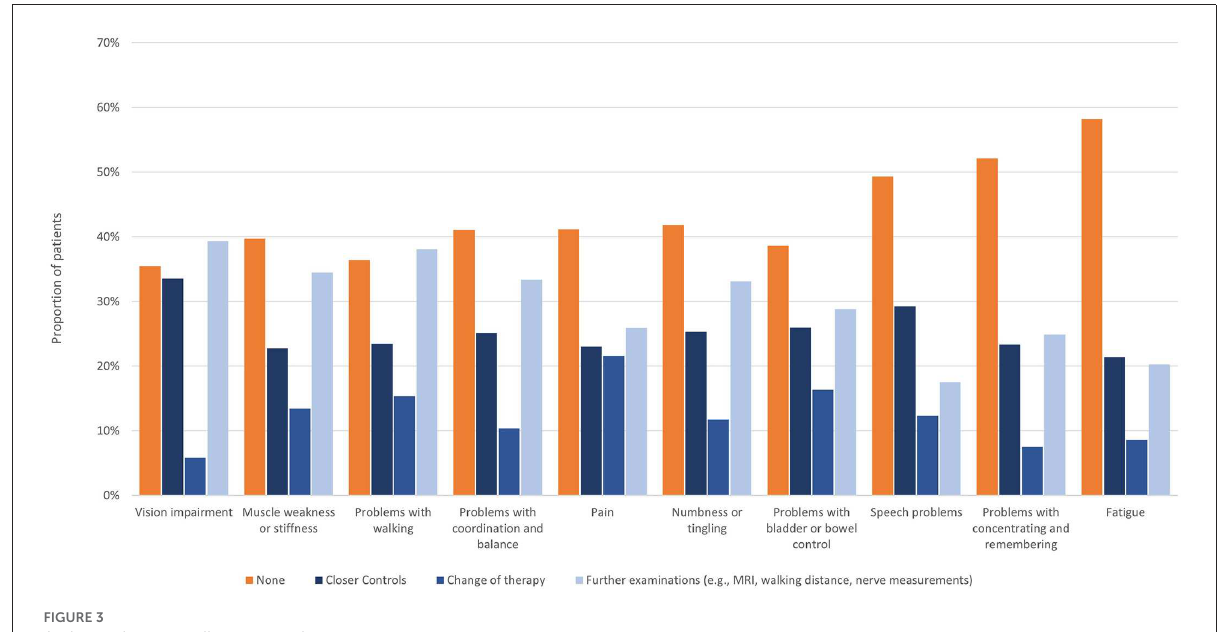
FIGURE3 Actions taken regarding reported symptoms.